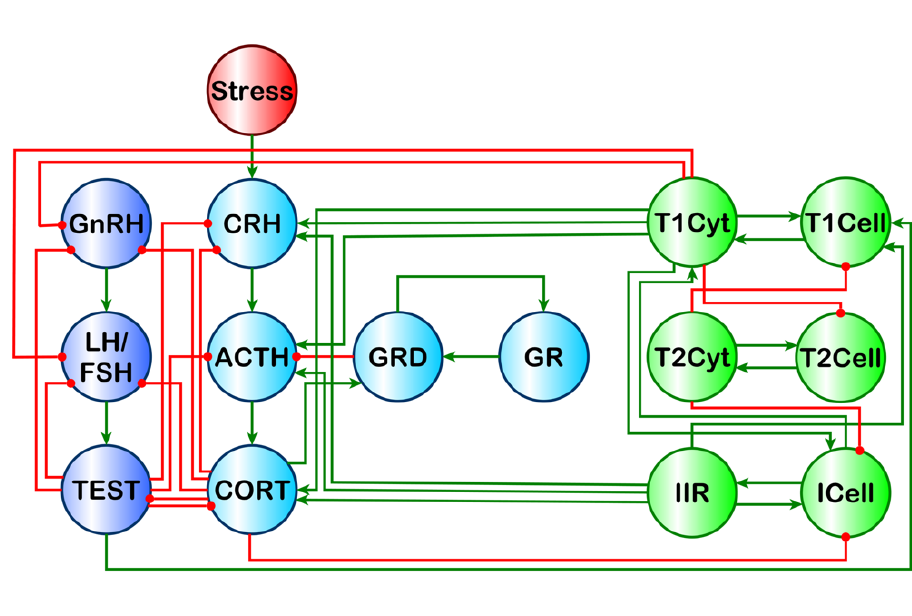
Figure 1. Theoretical male HPA-HPG-immune signaling network. Light blue nodes denote the HPA (hypothalamic–pituitary–adrenal) axis model described by Gupta et al., 2007 [17], comprising corticotropin-releasing hormone (CRH), adrenocorticotropic hormone (ACTH), cortisol (CORT), glucocorticoid receptor (GR), and the dimerized form of the glucocorticoid receptor which follows the binding of CORT (GRD). Dark blue nodes denote the male HPG (hypothalamic–pituitary–gonadal) axis comprised of gonadotropin-releasing hormone (GnRH), luteinizing hormone (LH), follicle-stimulating hormone (FSH), and testosterone (TEST). Green nodes denote a simplified immune system originally, described in [7], comprising innate immune response cytokines (IIR), innate immune cells (ICell), Type 1 T helper cells (T1Cell), Th1 cytokines (T1Cyt), Type 2 T helper cells (T2Cell), and Th2 cytokines (T2Cyt). The red node denotes the external influence of stress on the system. Green edges are stimulatory, and red edges are inhibitory. This image is a reproduction of the original found in [7] and presented